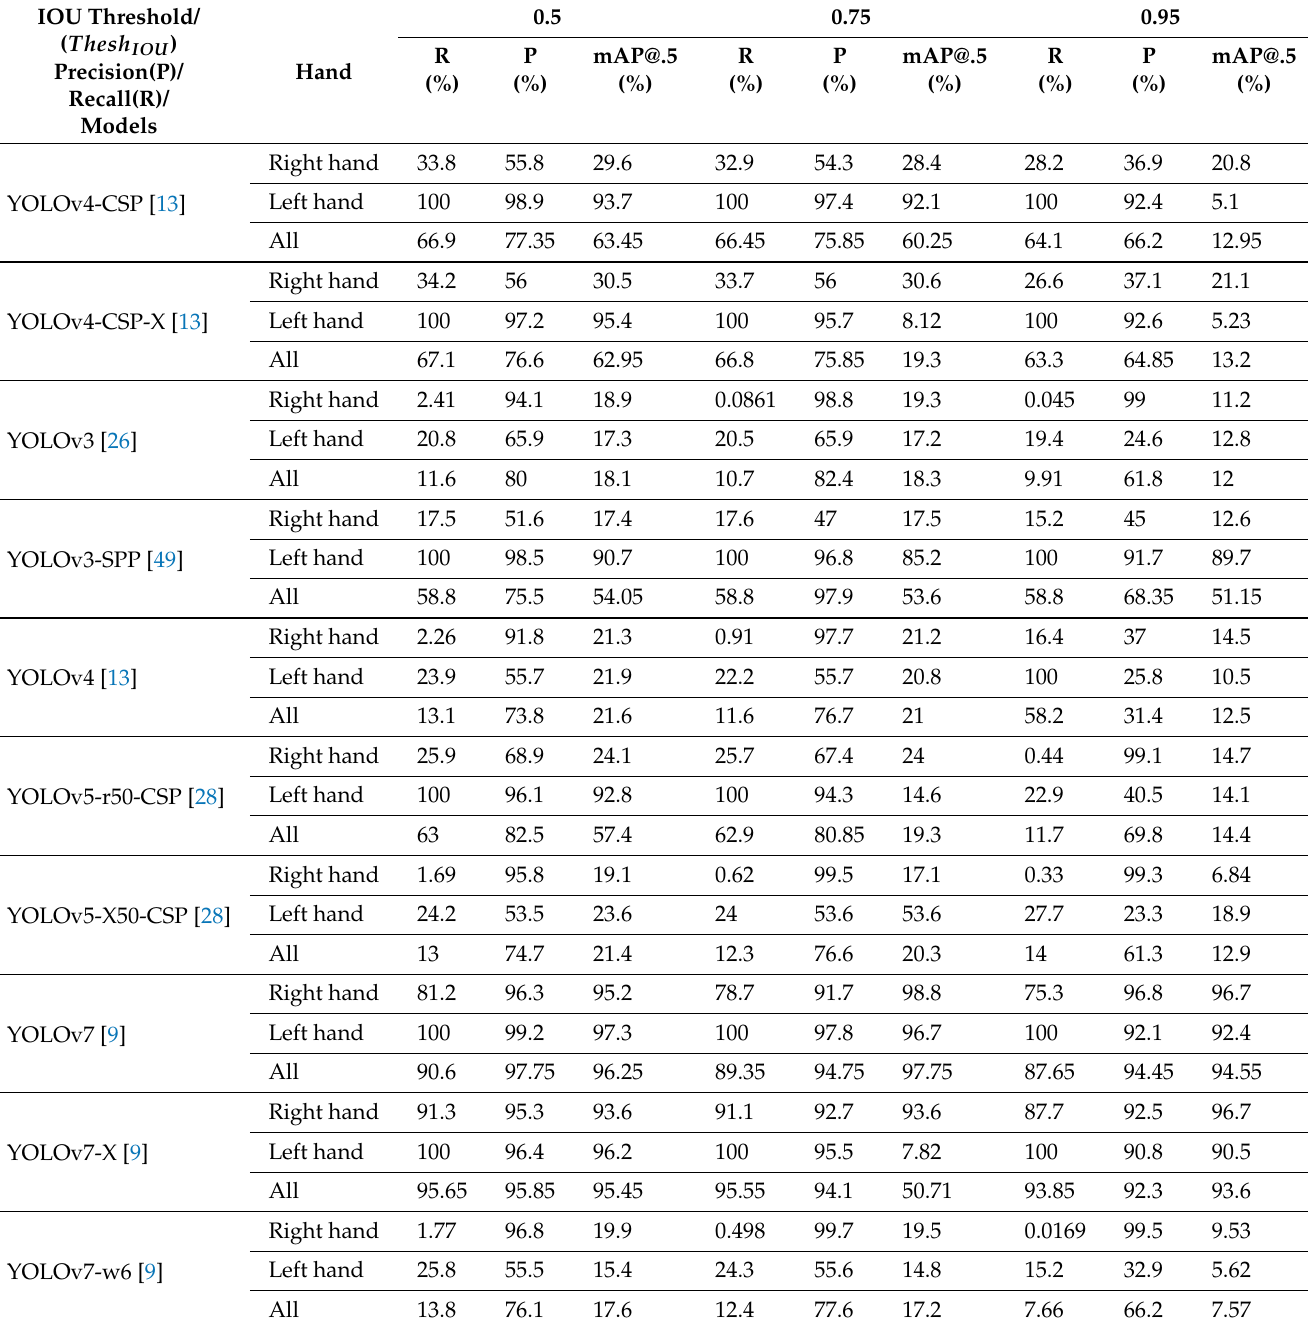
Table 4. The results of hand detection and classification on the RehabHand dataset